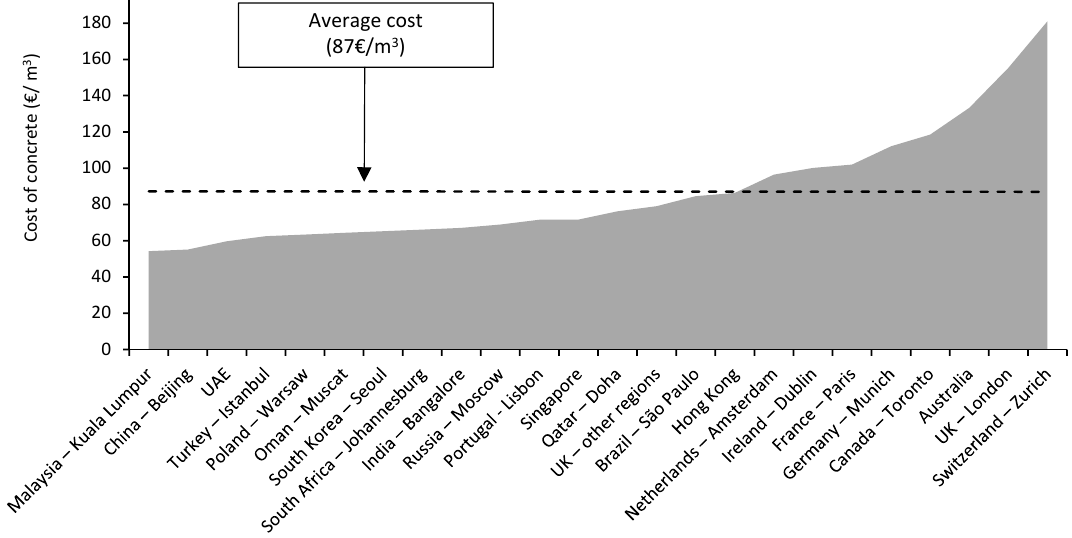
Figure 1. Cost of concrete (C30/37) in different countries excluding taxes (adapted from an international construction market survey in 2016 [1]).